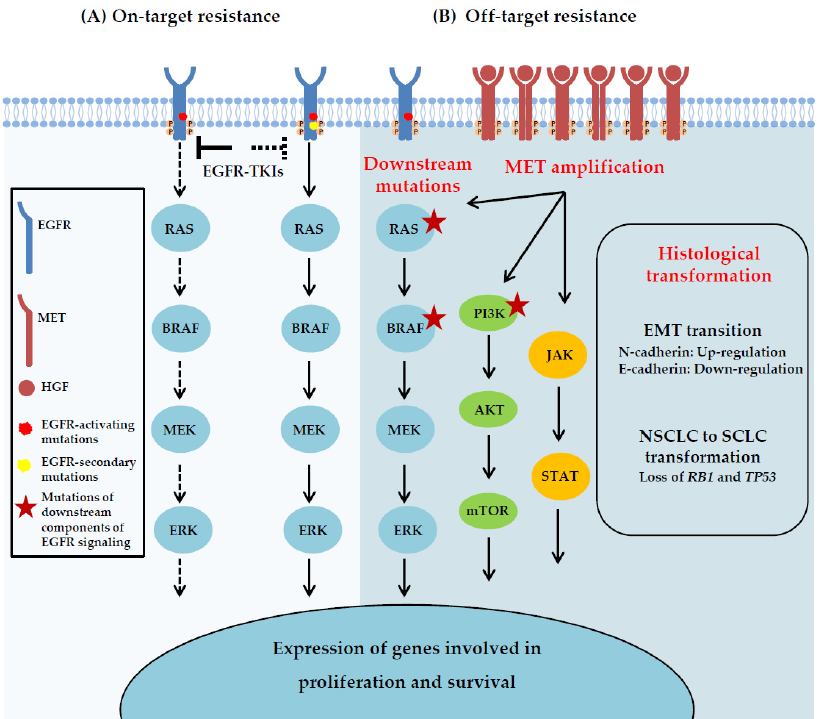
Figure 2. Acquired resistance mechanisms to EGFR-TKIs. ( A ) On-target resistance is caused by second-site EGFR kinase domain mutations that interfere with the binding of the EGFR-TKIs. ( B ) Off-target resistance may result from alterations involving downstream components of the EGFR pathway, activation of alternative signaling pathways that bypass the primary drug targets, including MET amplification, or transition to another cell lineage, such as epithelial-to mesenchymal transition (EMT) and SCLC